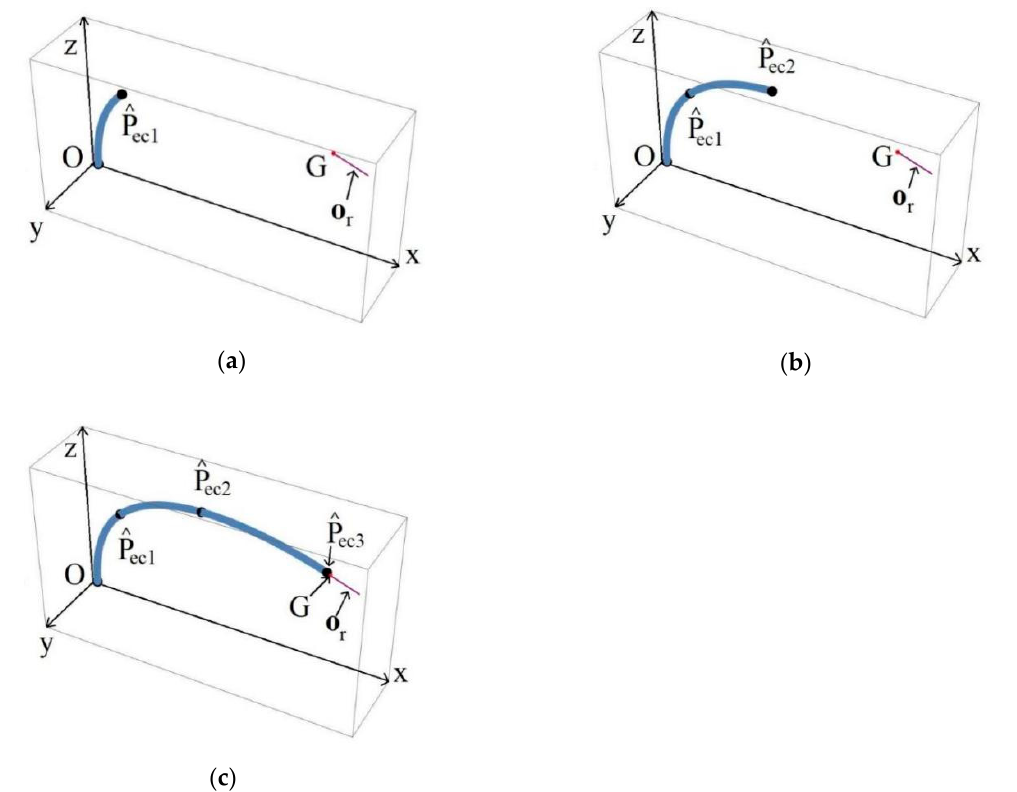
Figure 5. Approximate bent robot spine curve that reaches goal point G and is in vector o r orientation: ( a ) Preliminary bent robot spine curve first segment; ( b ) preliminary bent robot spine curve first and second segments; ( c ) preliminary bent robot spine curve—first, second, and third